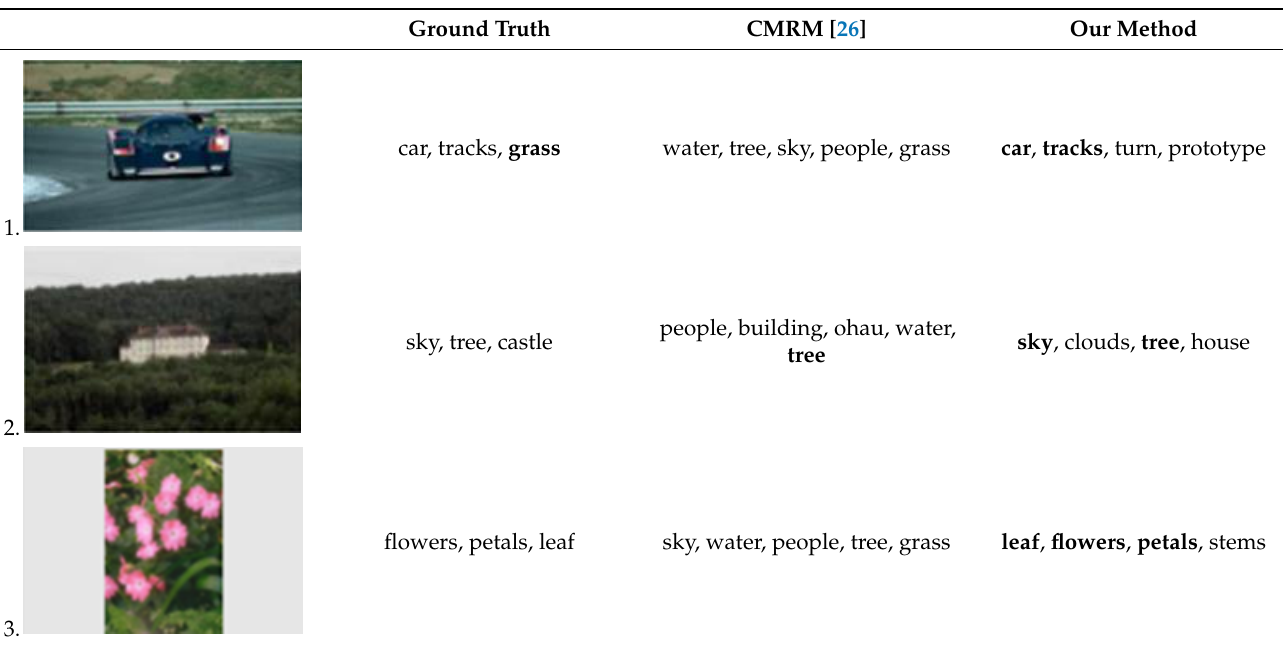
Table 3. A list of images with their respective ground truths and given annotations. Concepts in bold indicate that they are parts of the ground truth.